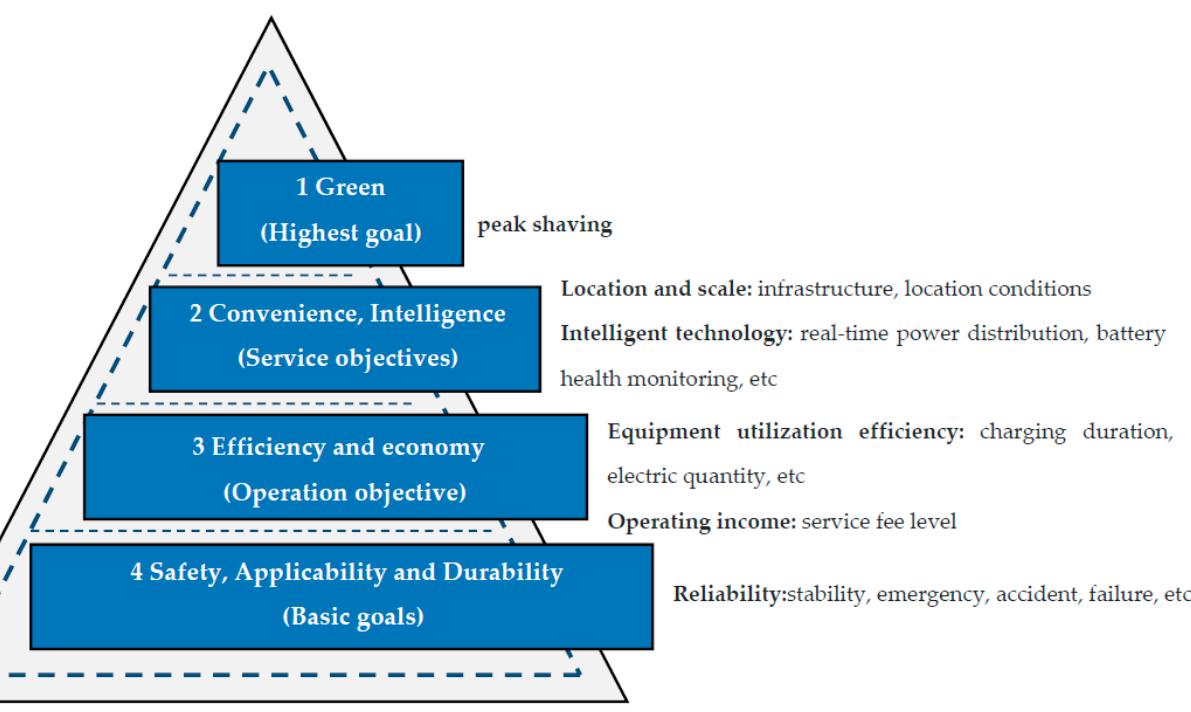
Figure 3. Basic influencing factors of electric bus charging station service evaluation.